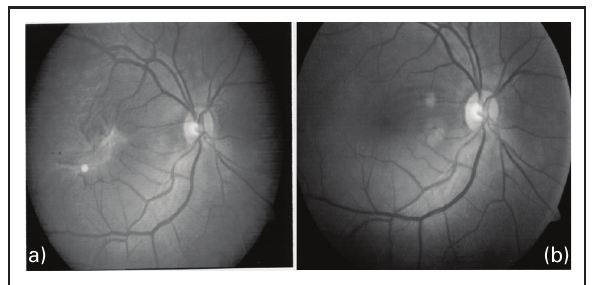
Figure 1. Fundus photo (a) before and (b) after sur- gery (1 year follow up).